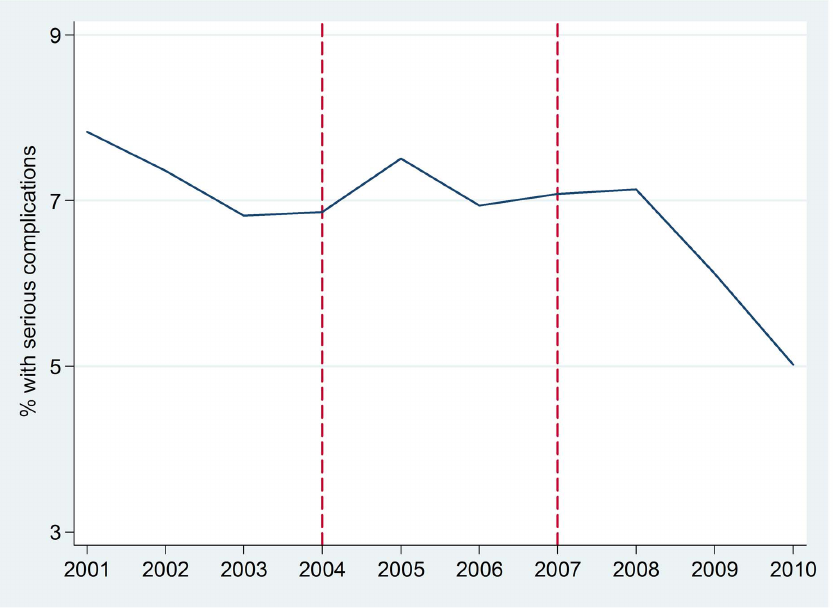
Figure 1. Trend in the percentage of abortion cases with serious complications presenting at four tertiary care hospitals in Nepal, 2001–2010, N=23,493. Early implementation, monthly IRR from segmented Poisson regression=1.002, p , .001; later implementation, monthly IRR=0.993, p , .001; marginal spline test for slope change, p , .001) Serious complications are those with infection (sepsis or septic shock, peritonitis, endometritis, severe pelvic or peritoneal infection, or body temperature . =102 F), evidence of foreign body or mechanical injury, systemic complications, such as organ failure, or death. 2002 - Passage of legal abortion legislation 2004 - First trimester services and trainings begin 2007 - Second trimester services and trainings begin 2008 - Midlevel providers trained and legally provide first trimester abortion 2009 - Medication abortion added to safe abortion program.